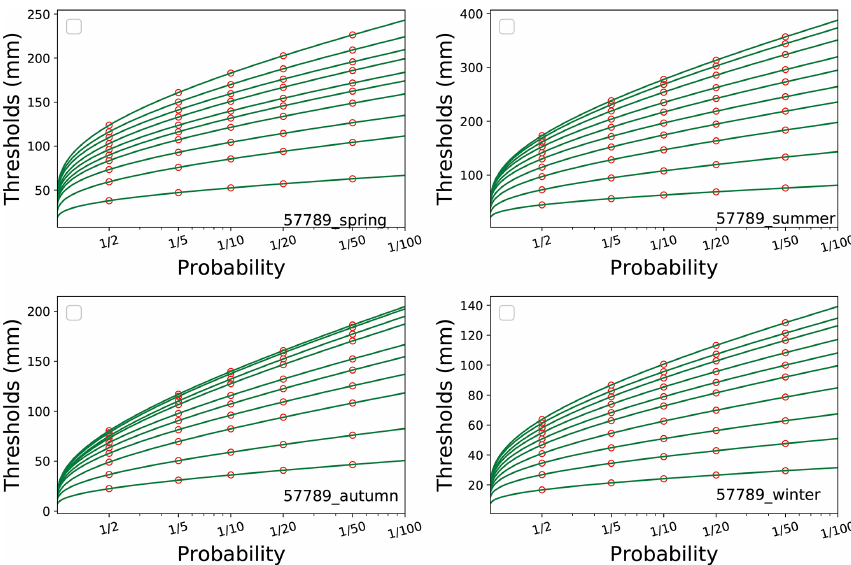
Figure 4. An example of extreme precipitation threshold distribution from the gamma fits of 1–10 runs of 12h data in seasons. The green lines from the bottom to top show the gamma fits of 1–10 runs, respectively. The hollow orange points are thresholds calculated with a probability of 0.5 (1 / 2), 0.2 (1 / 5), 0.1 (1 / 10), 0.05 (1 / 20) and 0.02 (1 / 50).